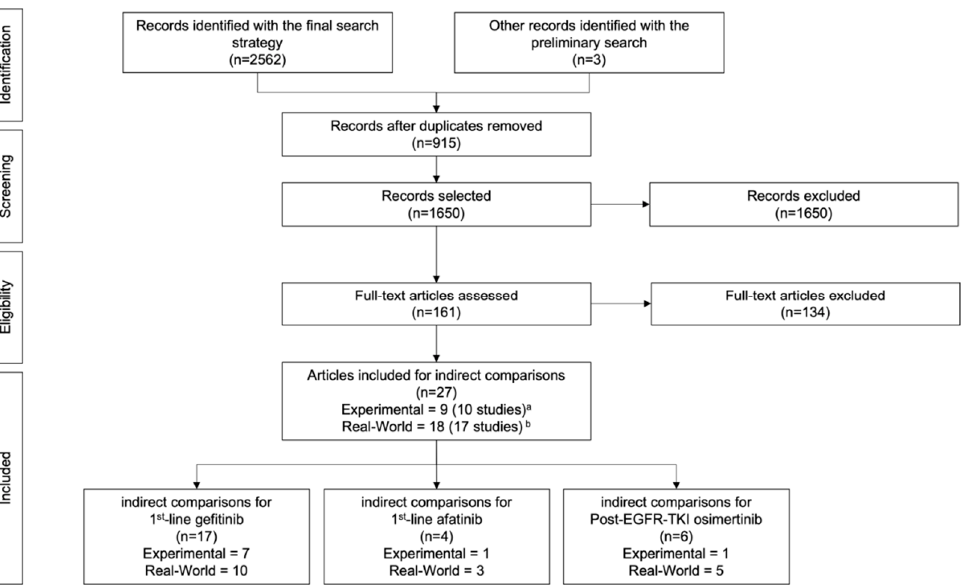
Figure A2. Flow Diagram of the Article Selection Process. a 1 article[28] included 2 randomized controlled trials (i.e., 2 studies) on afatinib as 1st ‐ line treatment. b 1 article[34], which included 1 real ‐ world study, was counted twice since it was used in the indirect comparisons of EGFR ‐ TKIs for 2 indications: 1st ‐ line gefitinib treatment and 1st ‐ line afatinib treatment.